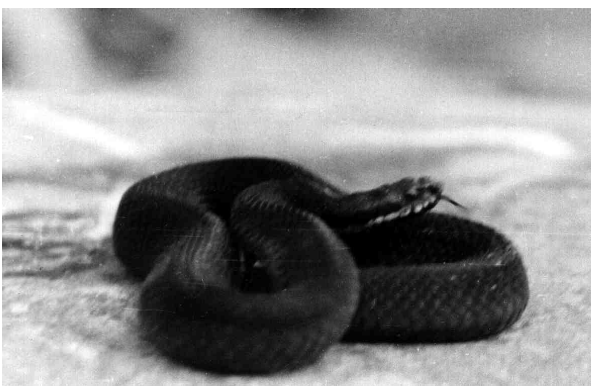
Figure 28. Wildlife inside of the sheltered station compound.